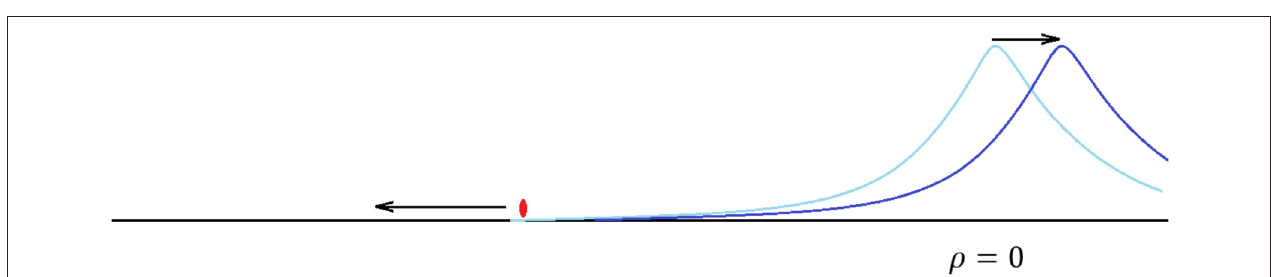
FIGURE 3 | A particle is introduced at the top of the potential, and subsequently rolls down the potential.